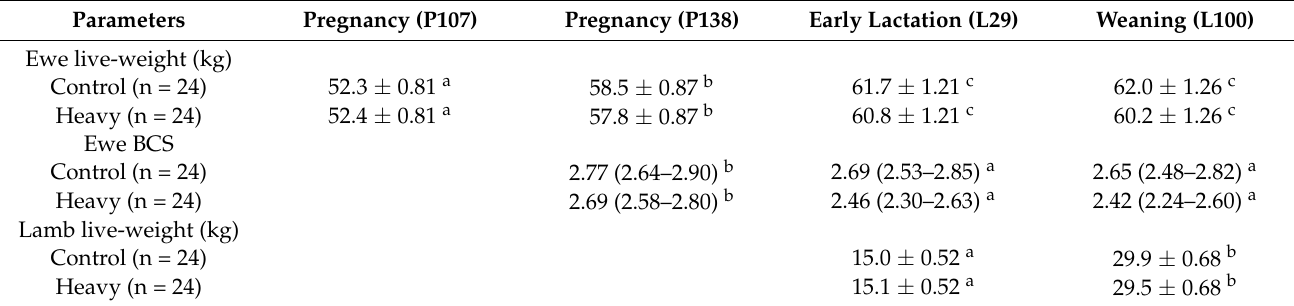
Table 2. Effect of time (P107, P138, L29, L100) and treatment group (control vs. heavy) on yearling ewe live-weight and body condition score (BCS) in pregnancy (P107, P138), early lactation (L29) and at weaning (L100) and lamb live-weight in early lactation (L29) and at weaning (L100). Least square means ± s.e for live-weight and least-square means (95% confidence intervals) for